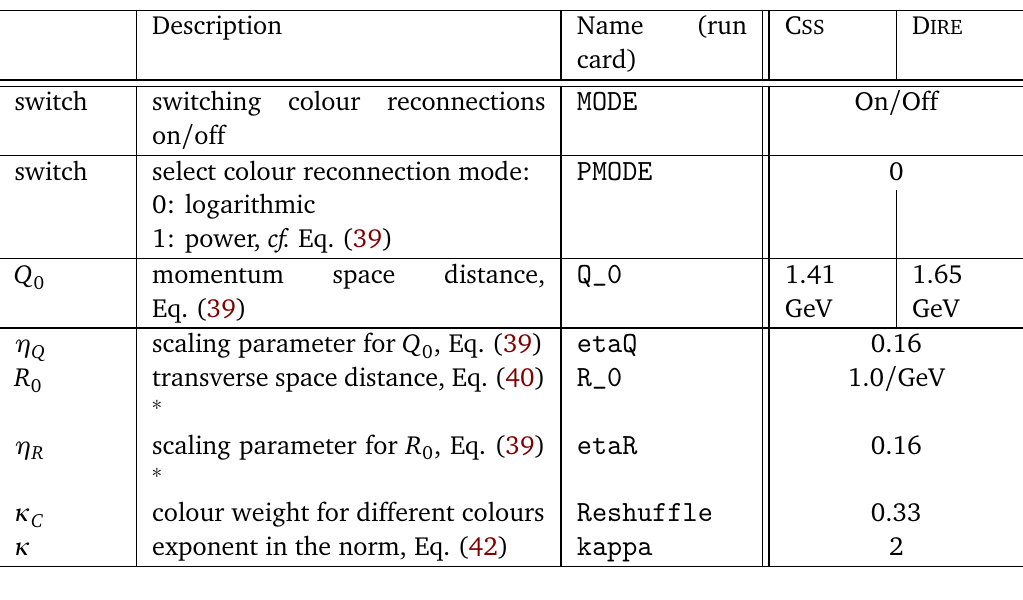
Table 7: Tuned parameters in the simple colour reconnection model provided in S HERPA , Section 3. ∗ Note that the spatial part of the model is relevant for hadron collisions only and will be tuned in conjunction with a forthcoming tuning of S HERPA ’s model for the underlying